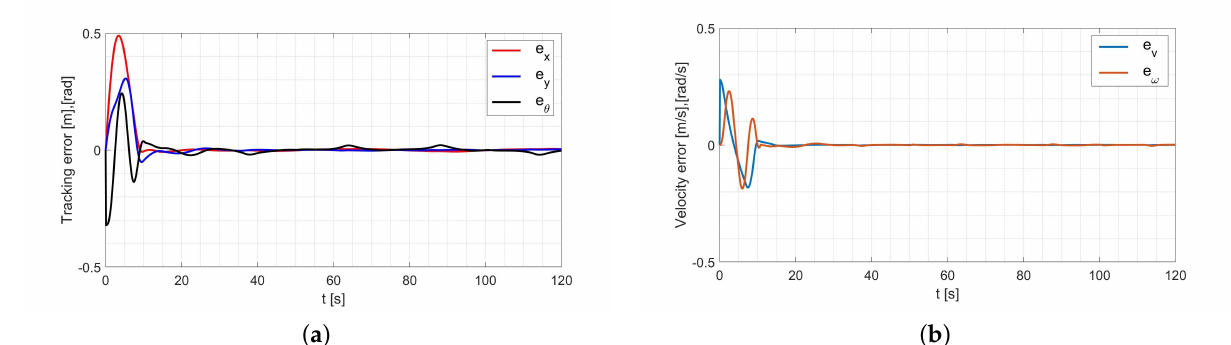
Figure 8. Errors for the Levenberg-Marguardt method: ( a ) reference trajectory tracking, ( b )